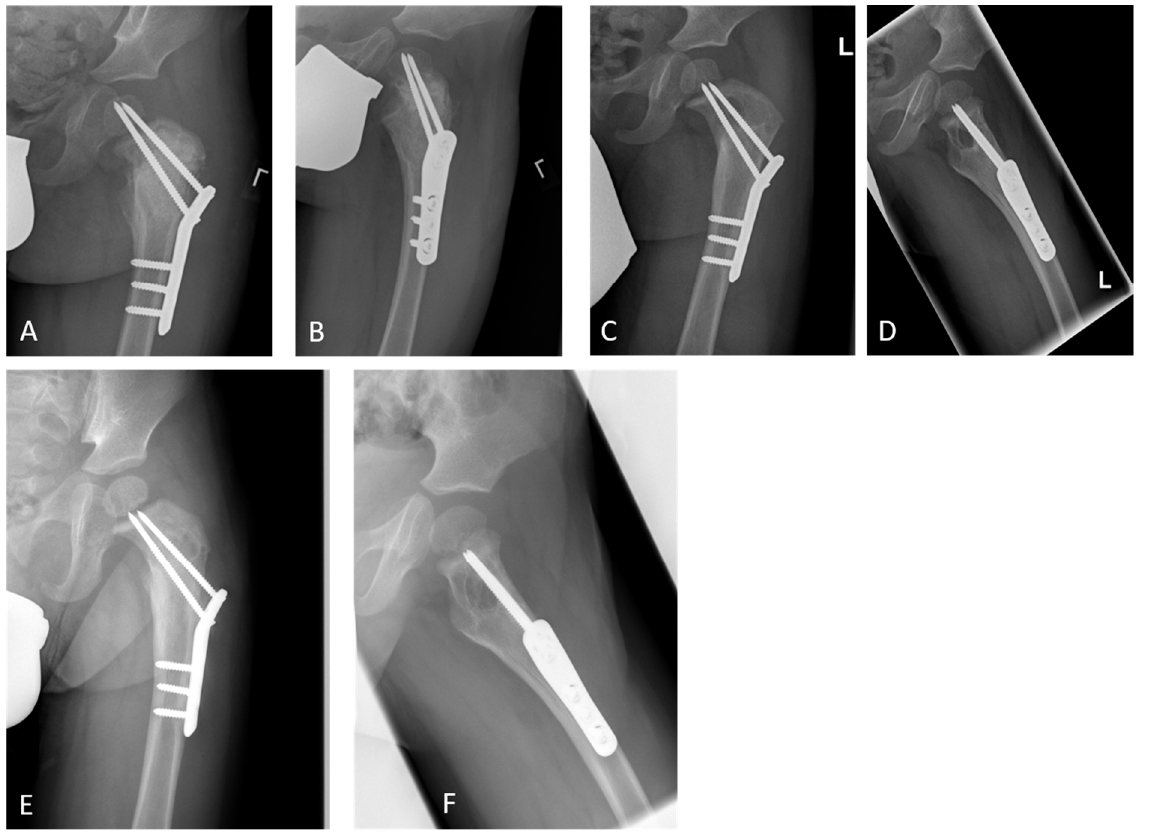
Figure 3. Radiological follow-up examination in the short and medium terms. After 6 weeks ( A , B ), the desired result was achieved, with a regular material position and filled cyst. The growth of the proximal femur over the physeal screws can been seen clearly in the displayed radiographs ( A – F ). However ( C , D ), radiological evidence suggests a recurrence, with the findings remaining stable for another 4 months ( E , F ).